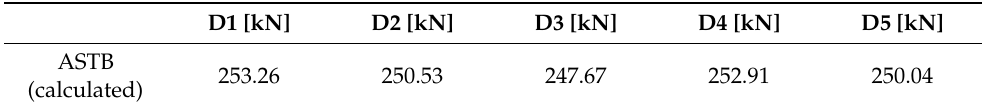
Table 7. Calculation results of ASTB reaction